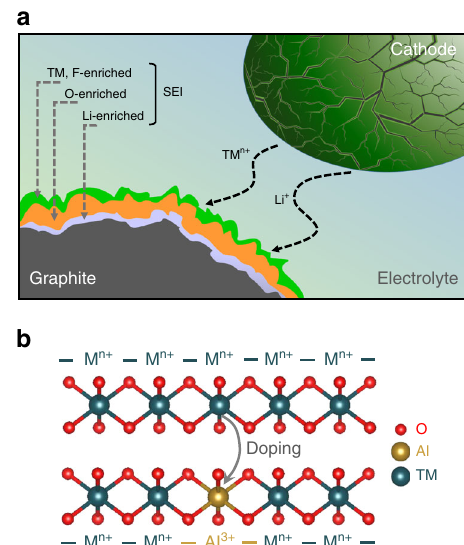
Fig. 5 Challenges associated with high-nickel layered oxide cathodes and the role of cation doping. a Schematic illustration of the dissolution and migration of transition-metal ions from the cathode to the graphite anode and the consequent catalytic formation of thick SEI layers on the graphite anode. ( b ) Substitution of transition-metal ions with a small amount of inert ion like Al 3 + that makes the lattice robust by perturbing the long-range metal-metal interaction and increasing the metal-oxygen bond strength and thereby suppressing metal-ion